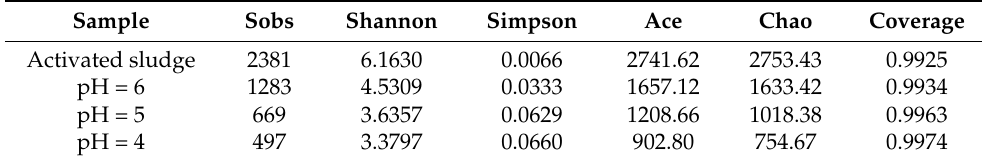
Table 1. α -diversity analysis of electroactive biofilms enriched on carbon